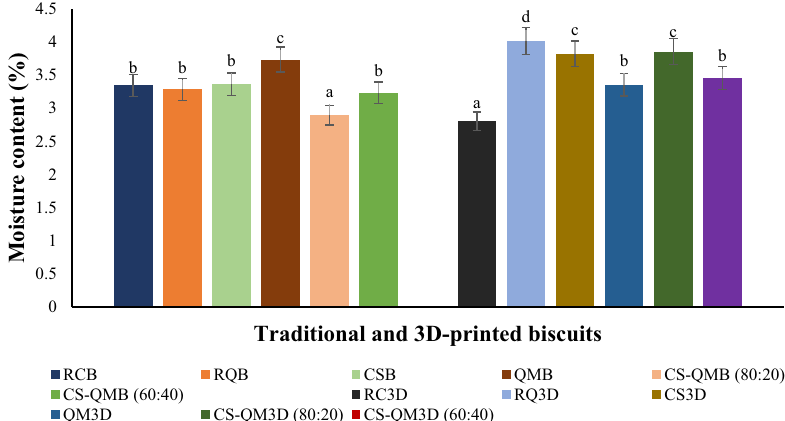
Figure 2. Moisture content of the raw, cowpea sourdough, and quinoa malt whole and multigrain biscuits. Averages of the moisture content depicted as bars with superscripts indicate significant differences ( p ≤ 0.05). RCB raw cowpea biscuit, RQB raw quinoa biscuit, CSB cowpea sourdough biscuit, QMB quinoa malt biscuit, CS-QMB ( 80:20 ) 80% cowpea sourdough and 20% quinoa malt biscuit, CS-QMB ( 60:40 ) 60% cowpea sourdough and 40% quinoa malt biscuit. 3D three-dimensional, RC3D raw cowpea 3D-printed biscuit, RQ3D raw quinoa 3D-printed biscuit, CS3D cowpea sourdough 3D-printed biscuit, QM3D quinoa malt 3D-printed biscuit, CS-QM3D ( 80:20 ) 80% cowpea sourdough and 20% quinoa malt 3D-printed biscuit, CS-QM3D (60:40) 60% cowpea sourdough and 40% quinoa malt 3D-printed biscuit.